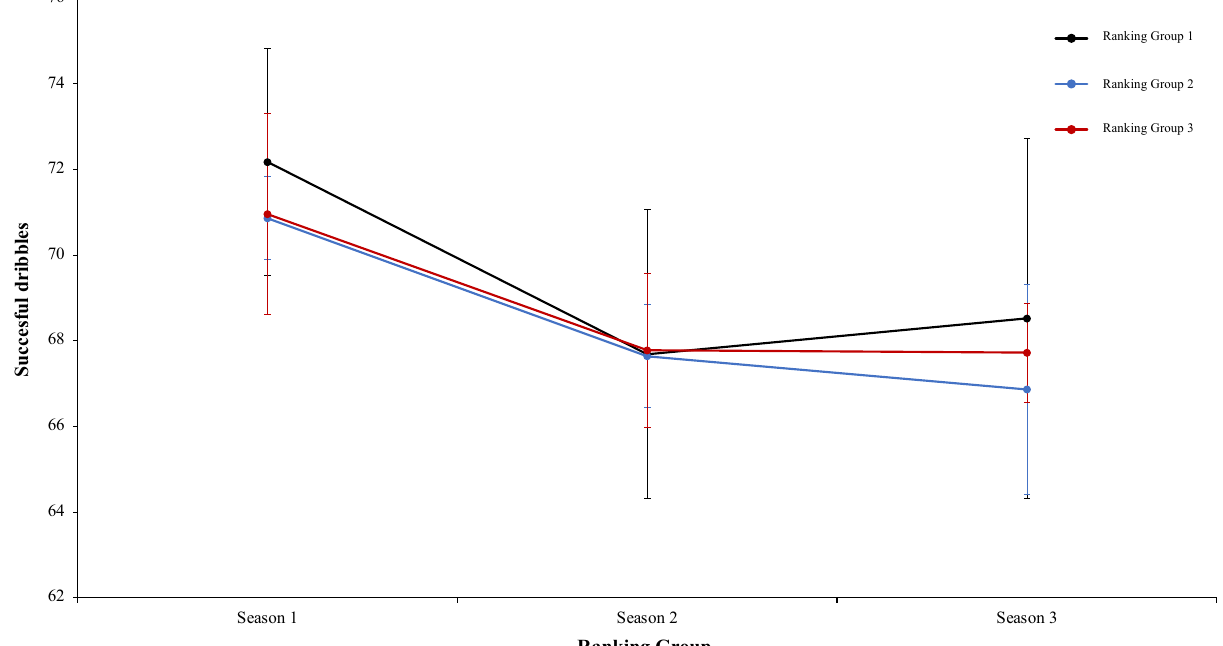
Figure 26. Technical performance. Means dribbling per match percentage (± SE) as a funtion of Group and Season Condition.